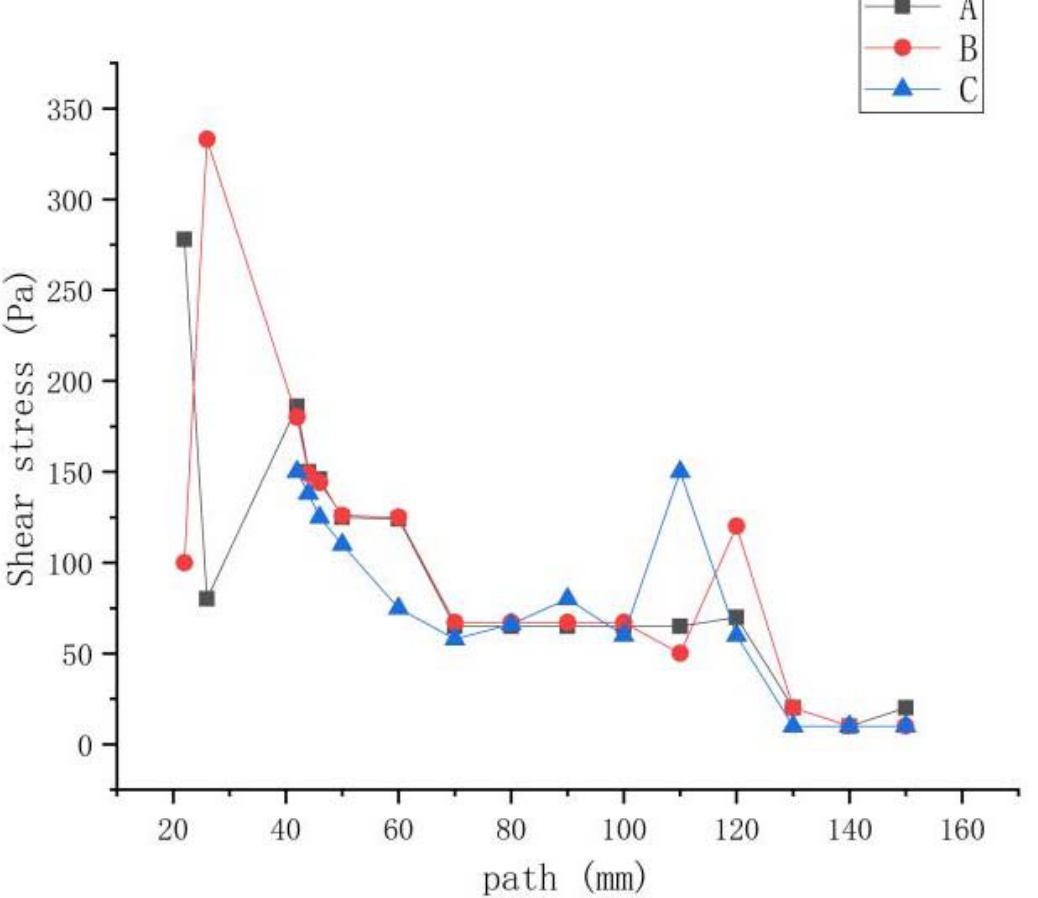
Figure 14. Amplitude of shear stress distribution.